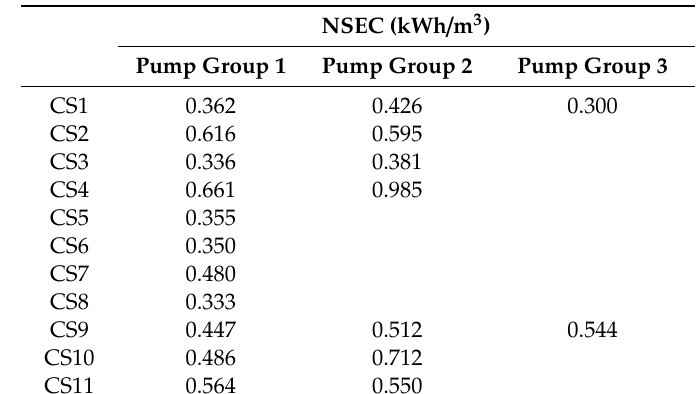
Table 10. Normalized specific energy consumption (NSEC) for each one of the pump groups of each